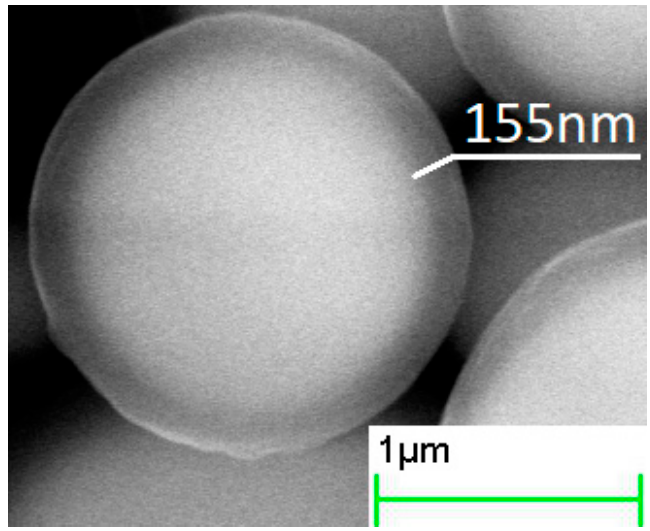
Figure 2. SEM images of core–shell particles obtained in the processes with 0.5 h hydrolysis dura- tion.